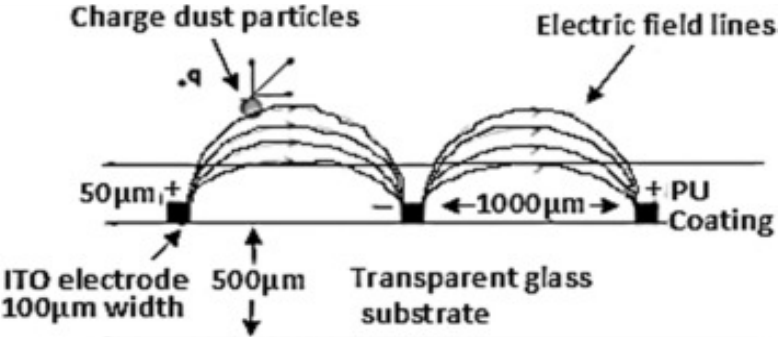
Figure 33. EDS Schematic diagram [143].